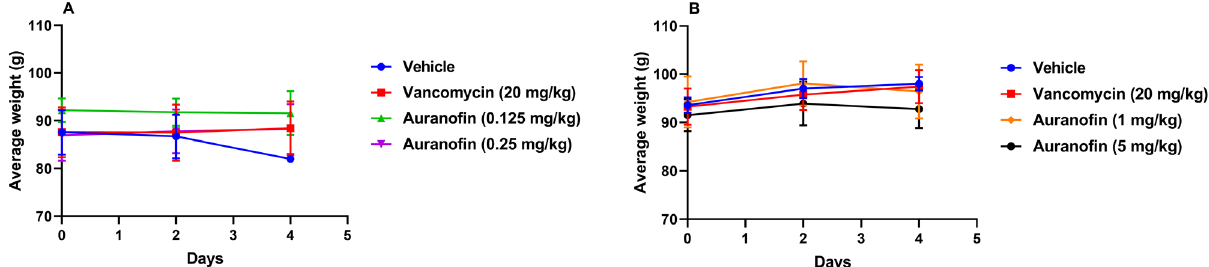
Figure 2. Average weight of surviving hamsters infected with C. difficile treated with: ( A ) low doses of auranofin (0.125 mg/kg and 0.25 mg/kg) and ( B ) high doses of auranofin (1 mg/kg and 5 mg/kg). Infected hamsters were treated with auranofin, vancomycin (20 mg/kg), or the vehicle for 5 days and weighed every other day. The data are presented as average weight (g) (mean ± standard deviation) for each group. A two- way ANOVA with post-hoc Dunnett’s test for multiple comparisons (P < 0.05) found no significant difference between the average weight for each group after receiving treatment, as compared to that before the start of treatment (day 0).